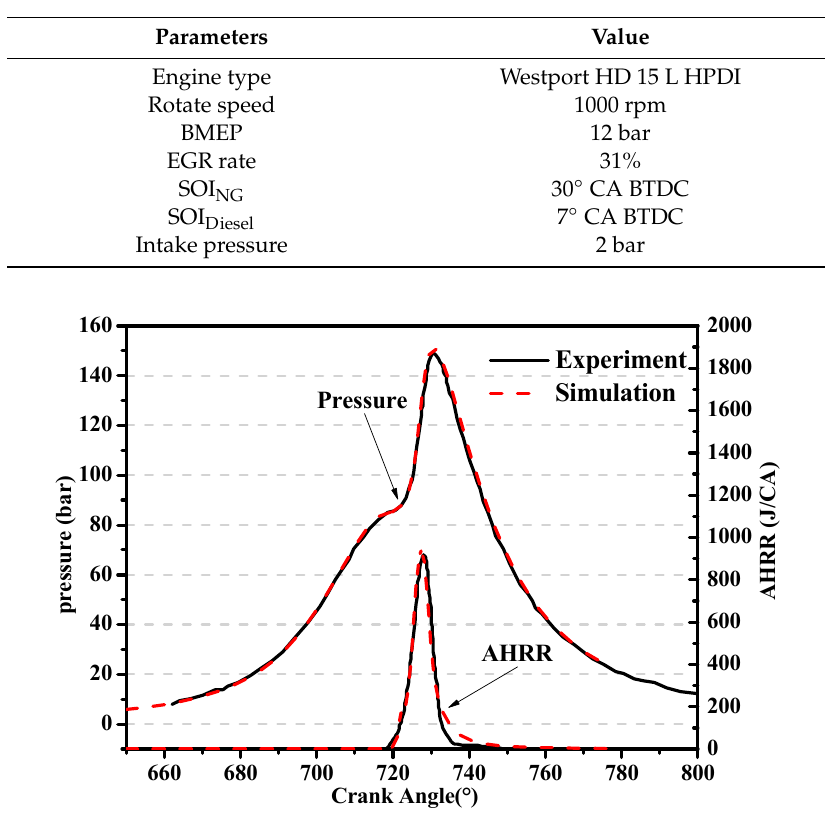
Figure 4. Comparison of simulation results and test data.